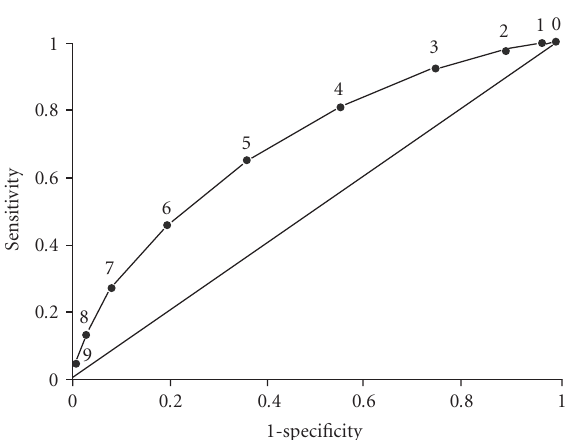
Figure 5: Receiver operating characteristic curve for total pretest score. Area under the curve is